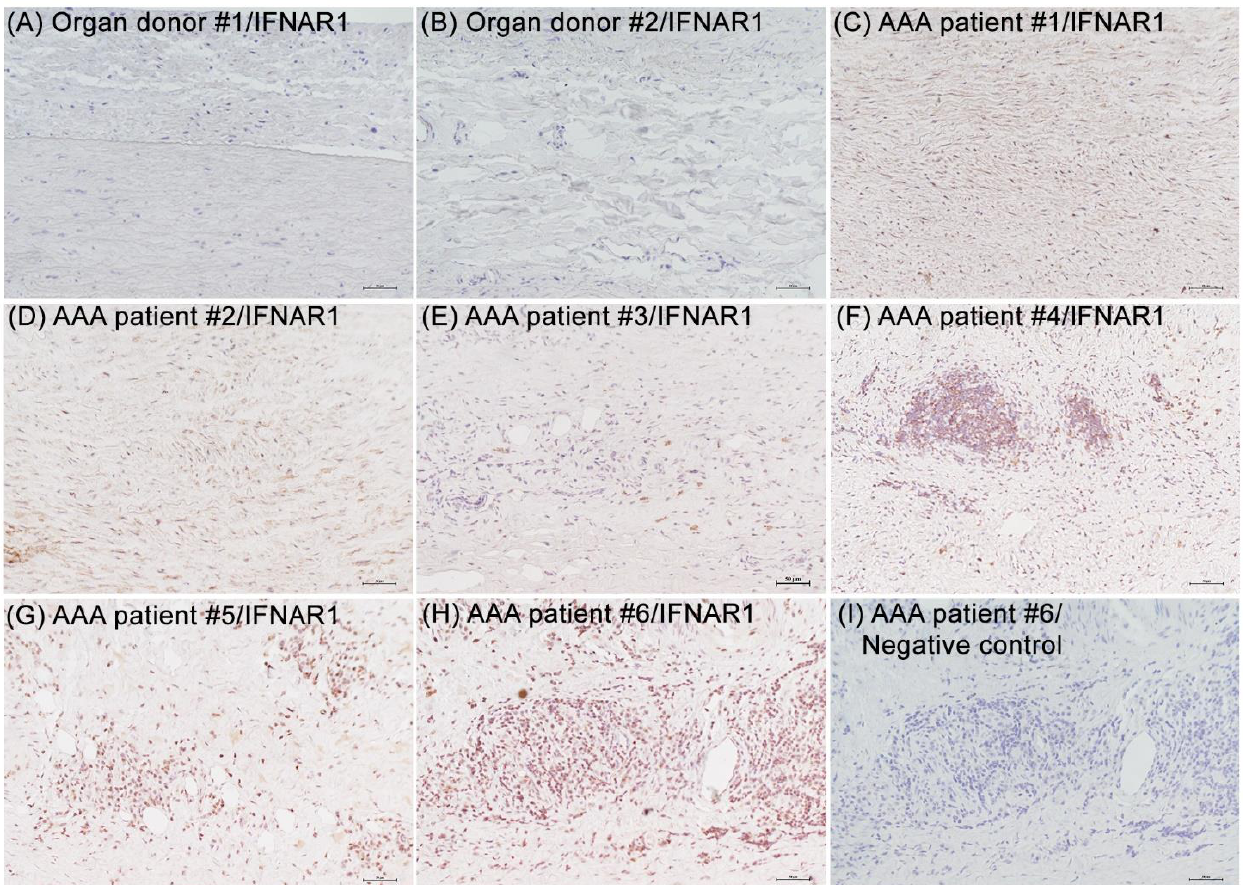
Figure 2. Immunostaining of type I IFN receptor subunit 1 in non-aneurysmal and aneurysmal human aortae. Formalin-fixed paraffin sections were prepared from aortic specimens harvested at organ donation (n = 2) or AAA repair (n = 6), stained with a rabbit anti-human type I interferon receptor subunit 1 (IFNAR1) polyclonal antibody or negative control antibody (normal rabbit IgG), and visualized with peroxidase substrate 3, 3′ -diaminobenzidine. ( A , B ) Rare or no IFNAR1 staining detected in organ donor aortae. ( C – H ) IFNAR1 staining was localized in the media and adventitia (within and outside of lymphocyte aggregates) of AAA specimens. ( I ) No staining noted in aneurysmal ( I ) and non-aneurysmal organ donor aortae (not shown) with negative control antibody. Scale bar: 50 μ m.